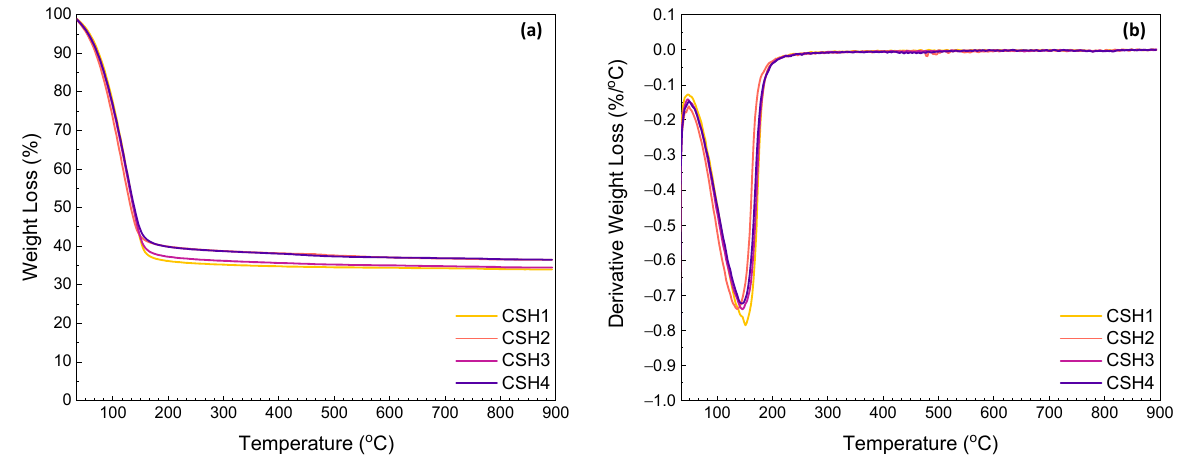
Figure 6. TGA ( a ) and DTG ( b ) curves for CSH gels at day 14. The second and the third weight losses that occurred in the ranges 350–500 ◦ C and 550–893 ◦ C are attributed to the dehydroxylation of portlandite (CH) and the decomposition of calcium carbonate due to carbonation of the CH, respectively. According to [48], three modes of calcium carbonate, which can coexist in the ultimate carbonation state of hydrated cement, can be identified from the differential TG (DTG) traces of calcium carbonate decomposition. The decomposition of well-crystallized calcite in the range of 780–990 ◦ C could define Mode I. Mode II is explained by the decomposition of carbonates by aragonite and vaterite at a lower temperature range of 700–780 ◦ C. Finally, the range of 550–700 ◦ C is related to the decomposition of amorphous calcium carbonate as Mode III. It was reported that the neat PAAm usually decomposes in multiple temperature ranges from 30 to 650 ◦ C, where the maximum weight loss (44.6%) occurs at about 540 ◦ C [49,50], which overlaps the thermal decomposition of calcium carbonate. The slight weight losses of the TGA and the corresponding shoulders of the DTG curves in the temperature range of 720–830 ◦ C indicate that the carbonation amount was ignorable with a slight formation of Mode I or II calcium carbonate.